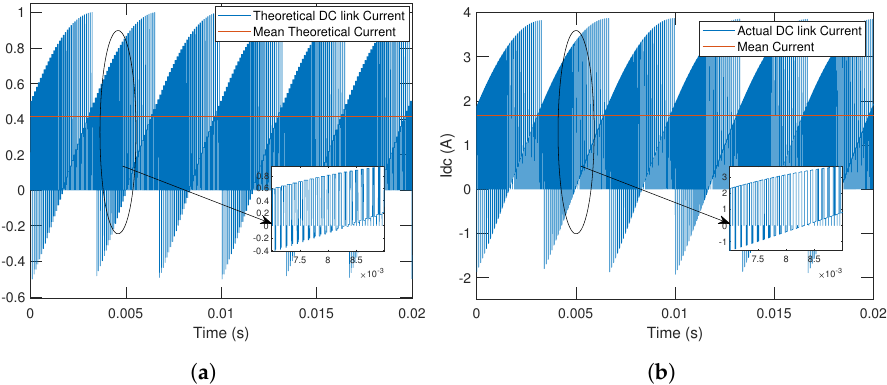
Figure 4. DC − link current for load pf angle = 45 ◦ . ( a ) Theoretically synthesized (using piece-wise formulation). ( b ) Its simulated